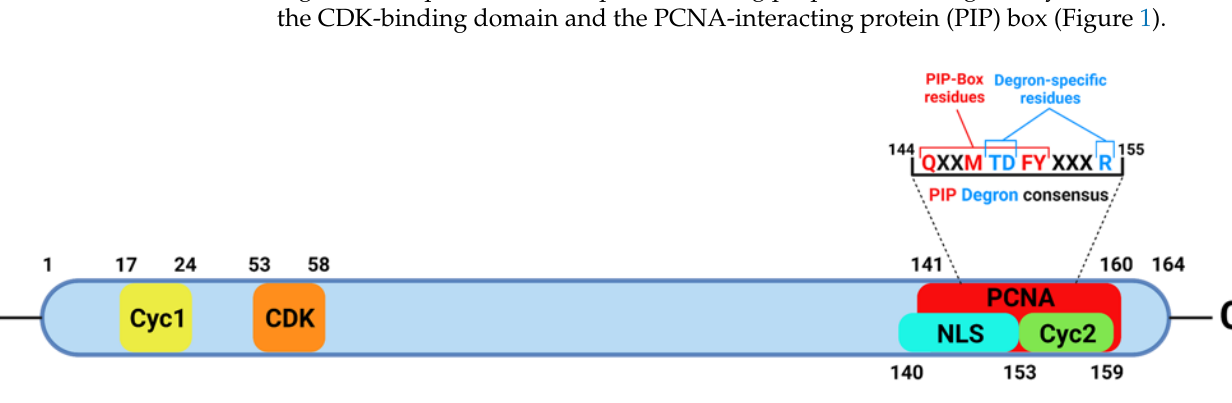
Figure 1. Schematic representation of p21’s structure, showing regions involved in the interactions with cyclins (Cyc1 and 2), CDK, and PCNA. The sequence of the PIP box and specific degron residues are also indicated. NLS—nuclear localization signal. Created with BioRender.com (Toronto, ON, Canada) (accessed on 10 May 2022).